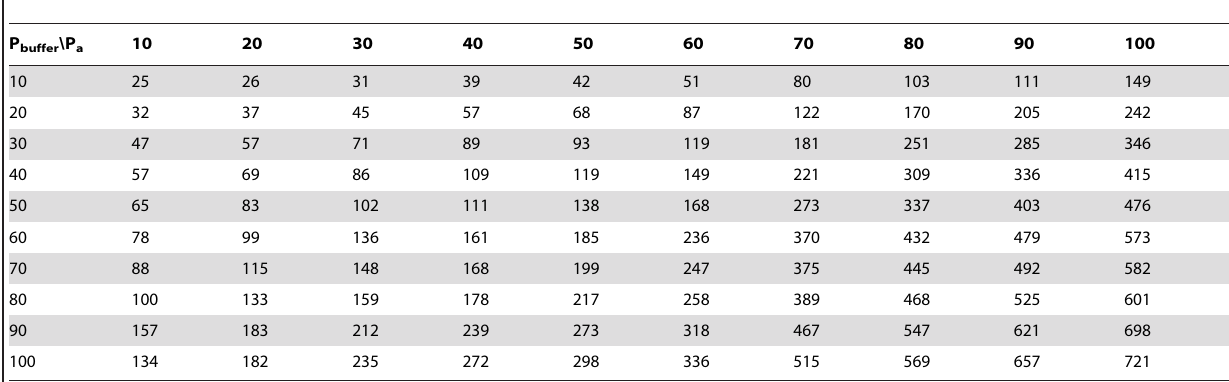
Table 2. TC (Time-Consuming, unit: second) of the proposed methodology with different parameters.